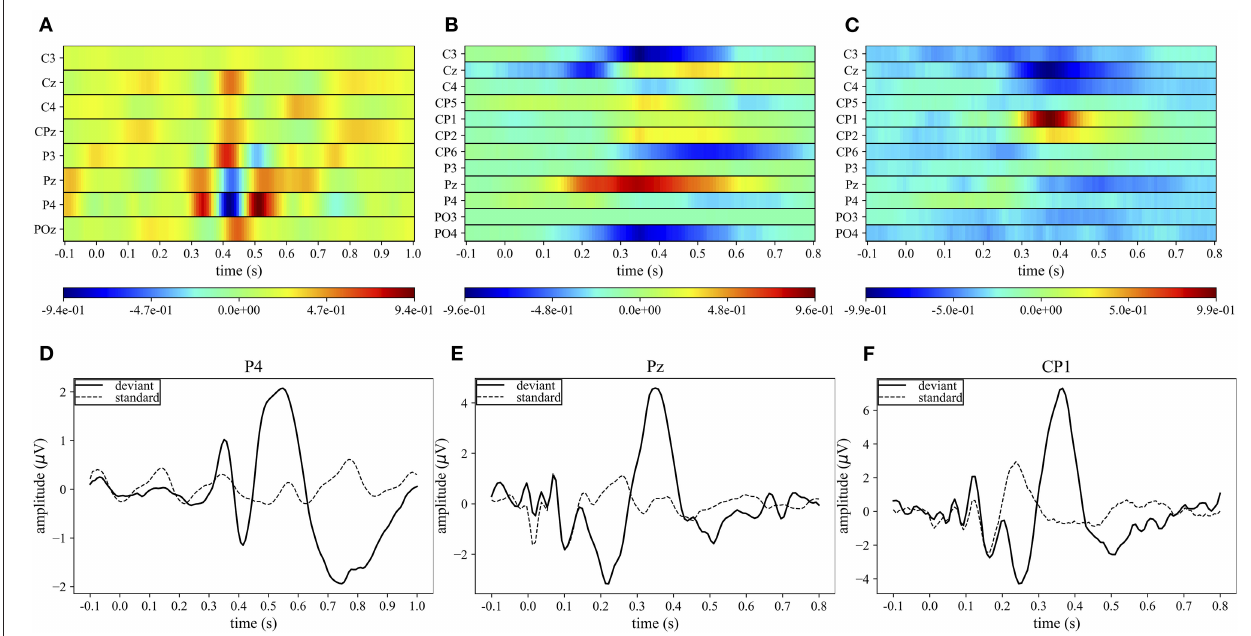
FIGURE 4 | Grand average spatio-temporal representations. The top panels (A–C) show the grand average spatio-temporal representation of MS-EEGNet trained with the LOSO strategy using signals from datasets 1–3. Positive gradients are shown in red, while negative gradients are shown in blue. The bottom panels (D–F) show the grand average ERP for the deviant (black lines) and standard (dashed black lines) stimuli associated with the most relevant electrode (the one with the largest gradient values) for datasets